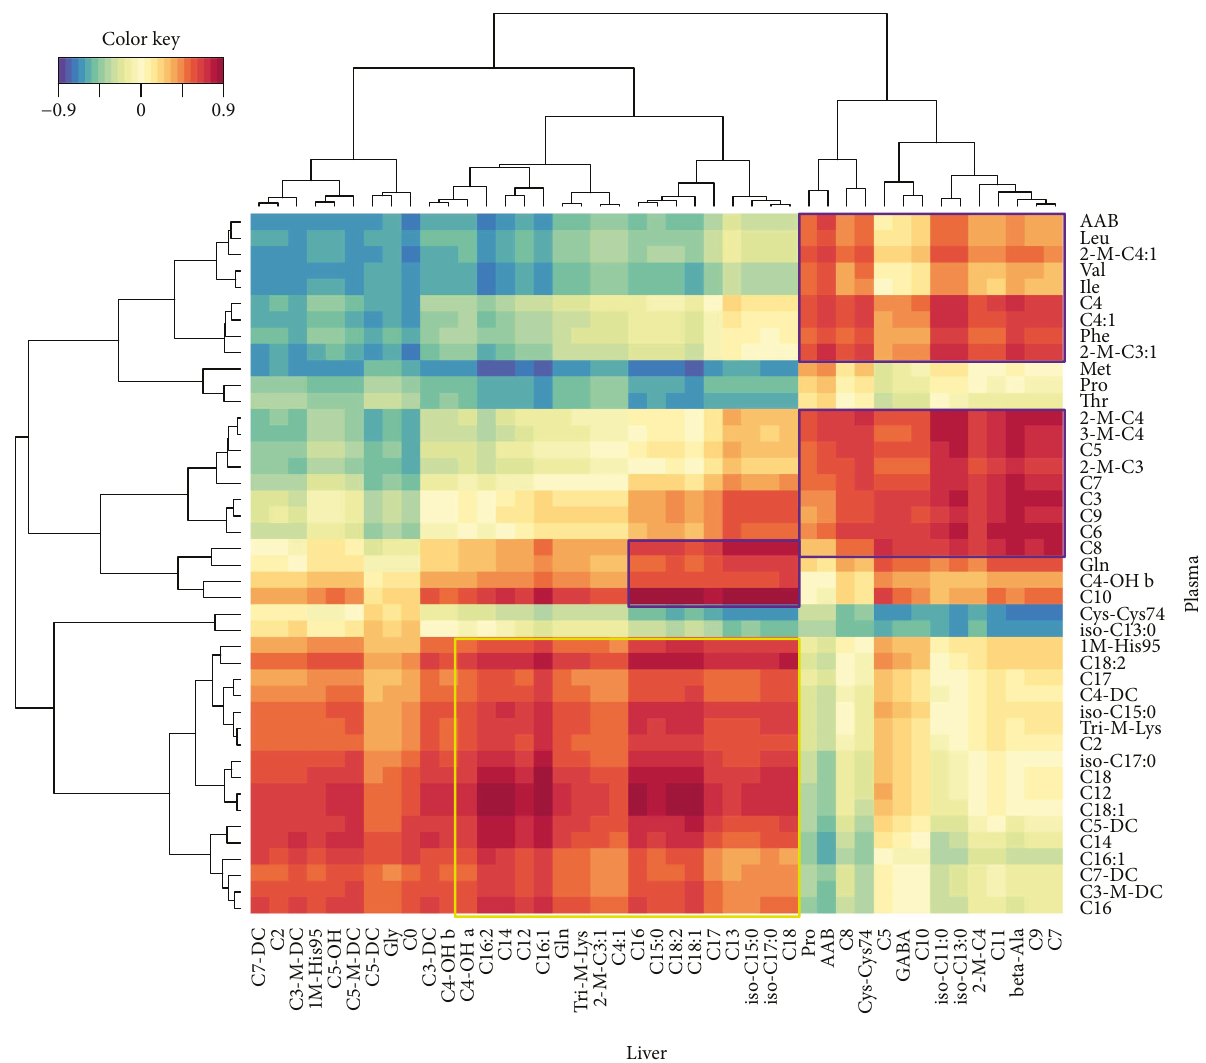
Figure 4: Heat map of hierarchical clustering of plasma and liver metabolites from diabetic (Md) and non-/prediabetic (M) male NZO mice. Highly correlating metabolites from plasma and liver are marked with coloured frames, while purple frames comprise mainly BCAA-derived and MCFA-derived ACs while yellow-marked frames comprise mainly LCFA-derived ACs. The threshold for the absolute correlation was set to at least 0.6. The colour scale re fl ects the distance score between each metabolite pair, with dark red indicating strong positively correlated pairs of metabolites and blue indicating strong negative